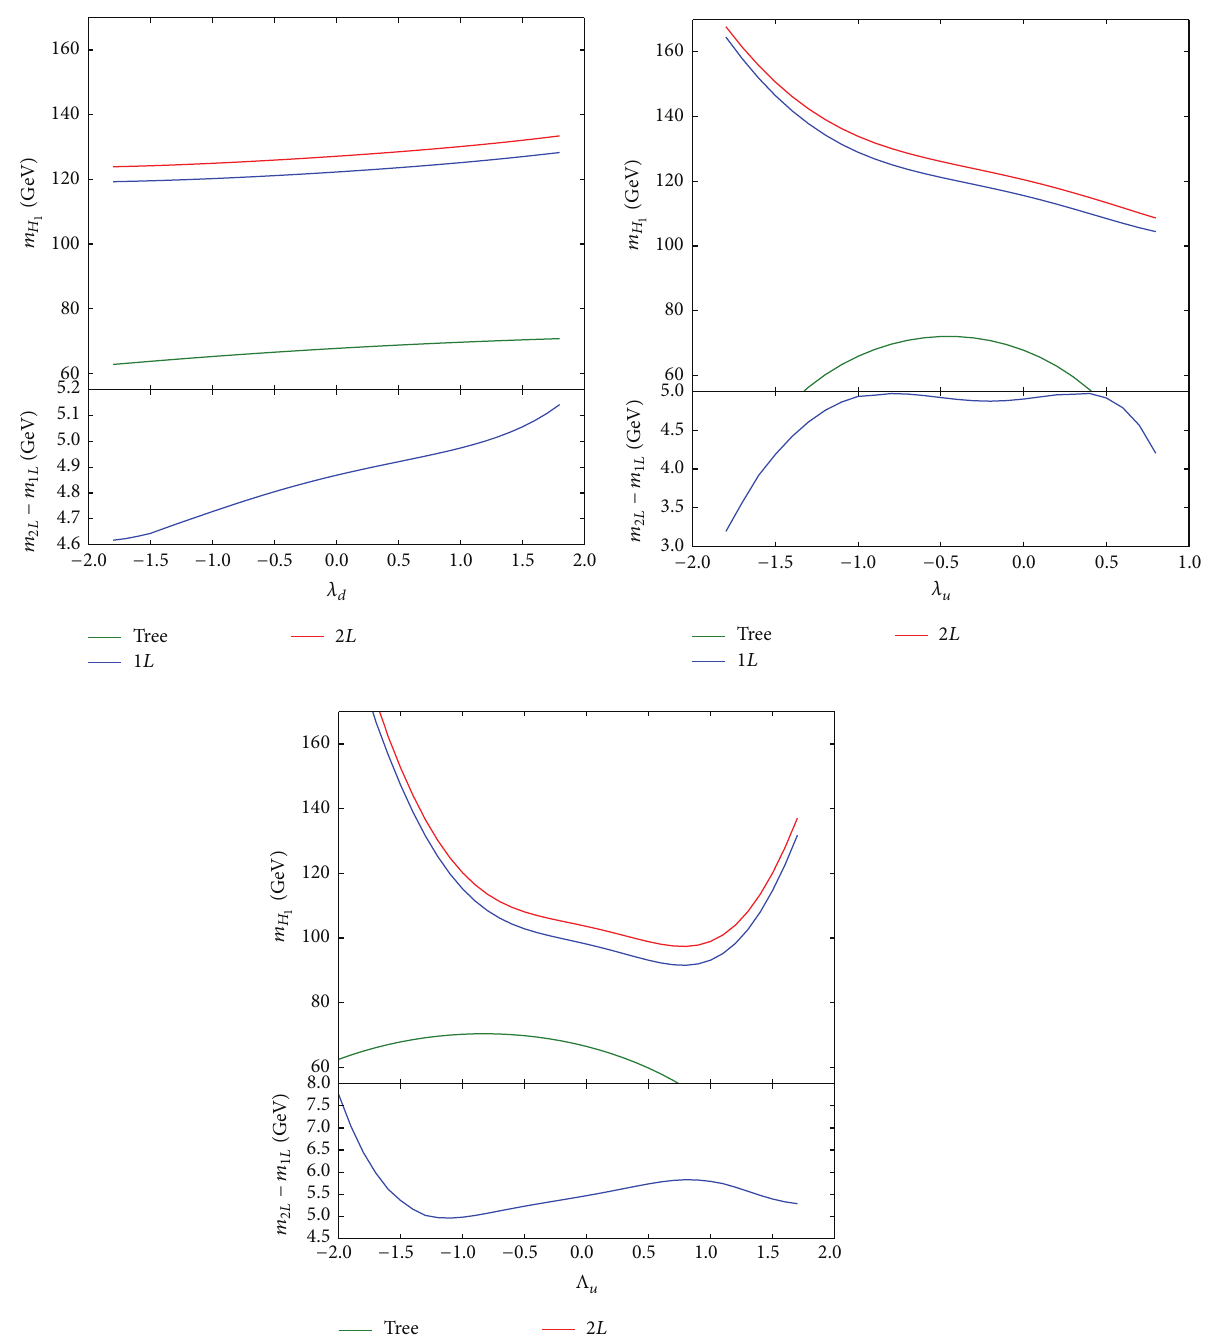
Figure 1: Lightest MRSSM Higgs boson mass 𝑚 𝐻 and the difference 𝑚 2 𝐿 − 𝑚 1 𝐿 between masses calculated at the two-loop and one-loop 1 level, as a function of 𝜆 𝑑 , 𝜆 𝑢 , and Λ 𝑢 , respectively. In the upper parts of the figure lines from top to bottom correspond to two-loop, one-loop, and tree-level calculations. All other parameters are set to the values of benchmark point BMP1 with tan 𝛽 = 3 (see Table